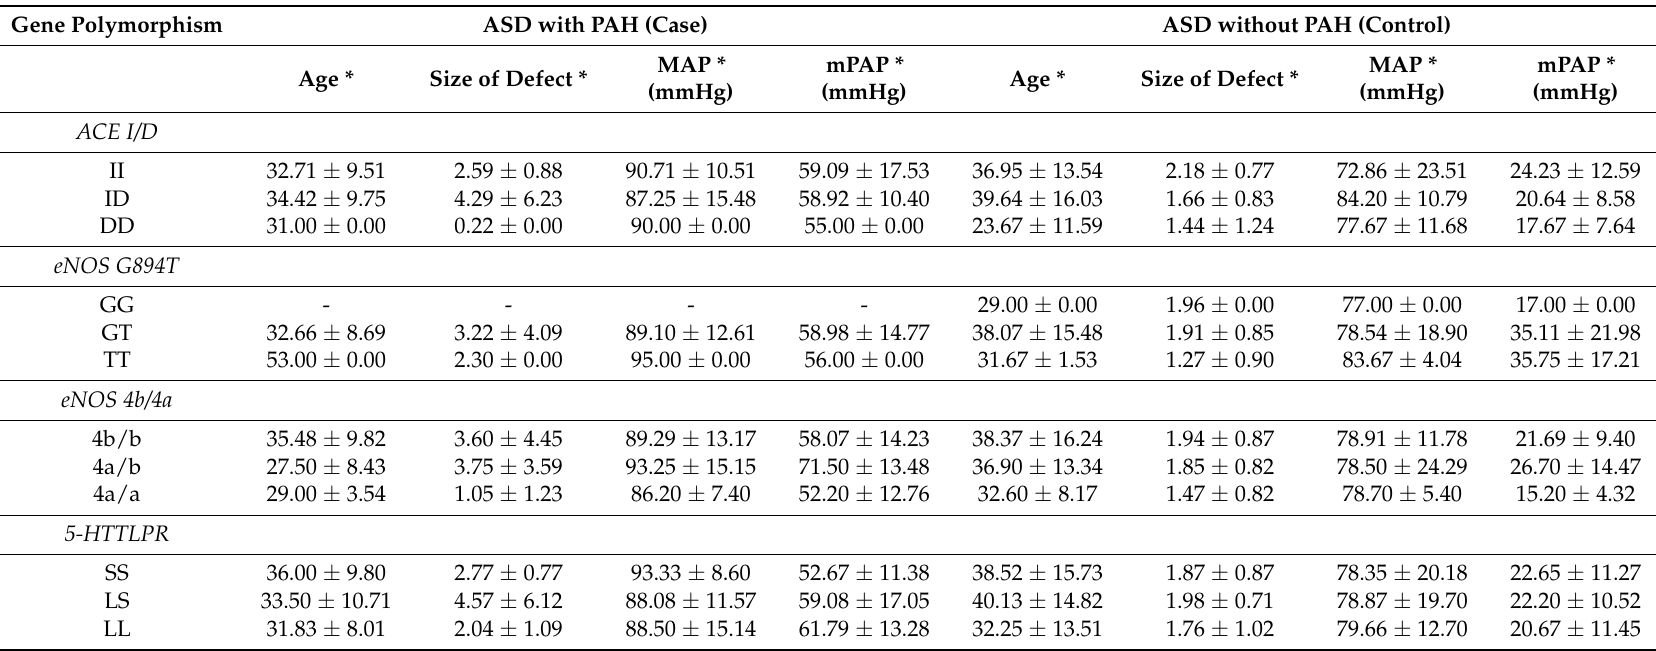
Table 4. Distribution between polymorphisms and clinical characteristics of the